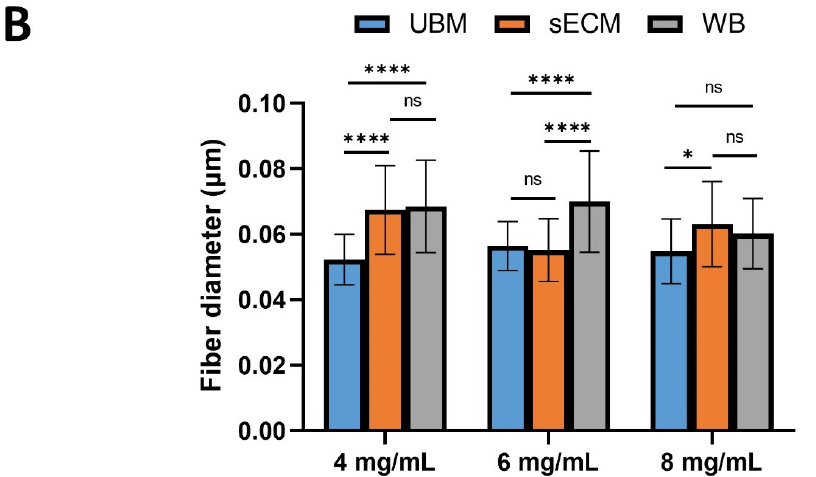
Figure 4. Surface morphology of hydrogels from UBM, sECM and WB (scale bar 2 µ m) ( A ). Fiber diameter was calculated using ImageJ with average of 30 fibers per group ( B ). *, **** denote statistical difference within the same group with p < 0.05, 0.0001, respectively ( n = 30).